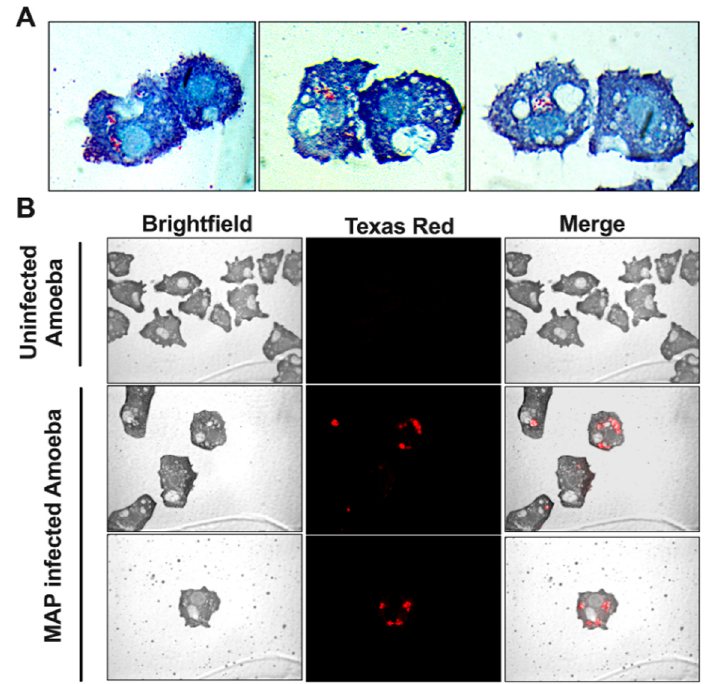
Figure 1. Amoeba readily phagocytize MAP during infection. Amoeba was incubated with either non-labeled ( A ) or carbol-fuchsin labeled ( B ) MAP at multiplicity of infection (MOI) of 10 and, after 1 h incubation, processed for Kinyoun acid-fast staining ( A ) or visualized under fluorescent microscopy ( B ). In micrographs, MAP is localized within the phagosome vacuoles and captured as red bacilli. Images are taken at 100× ( A ) and 40× ( B ) magnification and include uninfected amoeba as well.